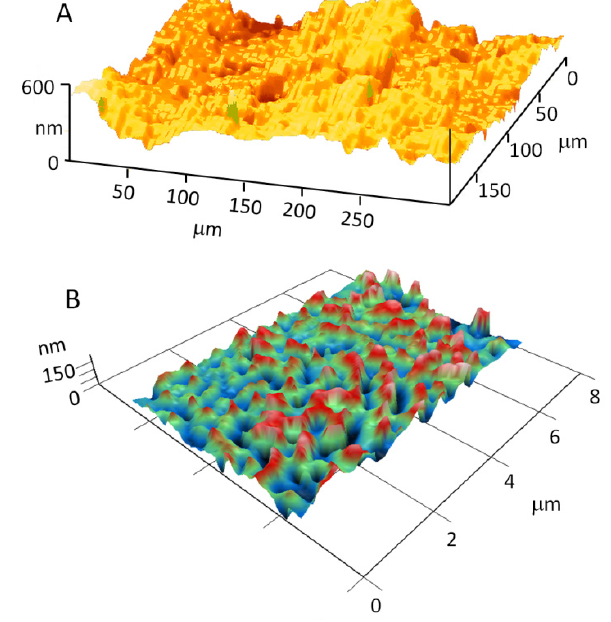
Figure 3. Topology of the Ti–25Nb–13Ta–5Zr alloy surface. ( A ) Analysis of surface topology using an atomic force microscope. ( B ) Analysis of surface topology study using a laser modulation interference microscope.